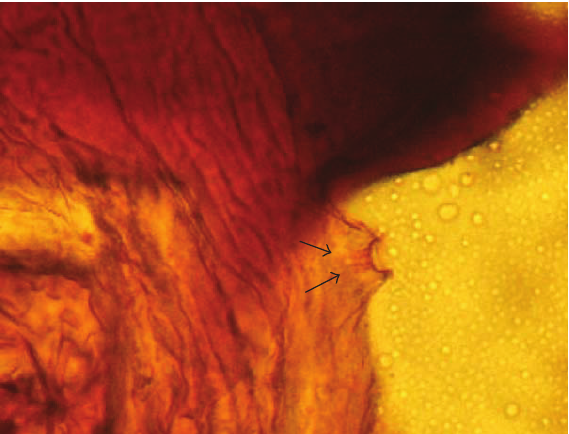
Figure 27: The sternal papillae in ectal view appear to be conical with paired structures internally (arrows), suggesting that they have a sensory function.